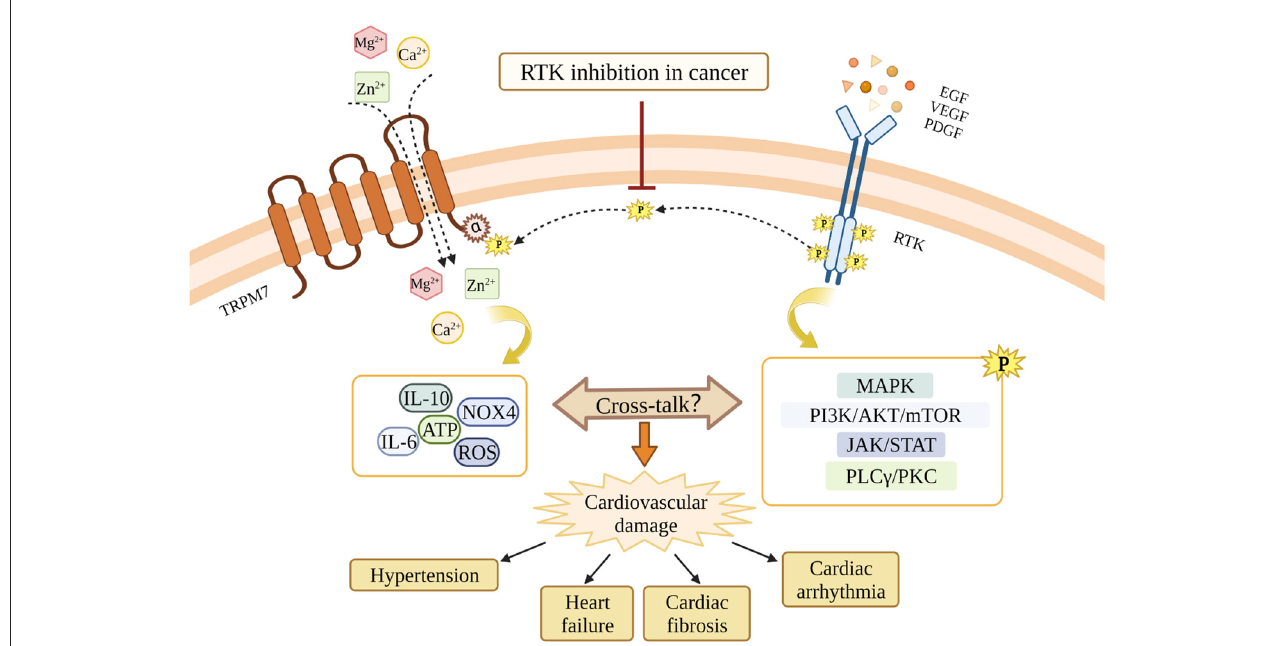
FIGURE3 Potential cross-talk between RTKs and TRPM7 and the potential involvement in RTKs inhibition-related cardiovascular toxicity. RTKs inhibition blocks the interaction between RTKs and TRPM7, and leads to TRPM7 dysfunction. Through mechanisms involving TRPM7, RTKs inhibition might cause cardiovascular damages in cancer patients. The MAPK pathway, the PI3K/AKT/mTOR pathway, the JAK/STAT pathway, and the PLC γ /PKC pathway are downstream signaling cascades activated by RTKs. The dashed line indicates the possibility that RTKs and TRPM7 interact. This still awaits